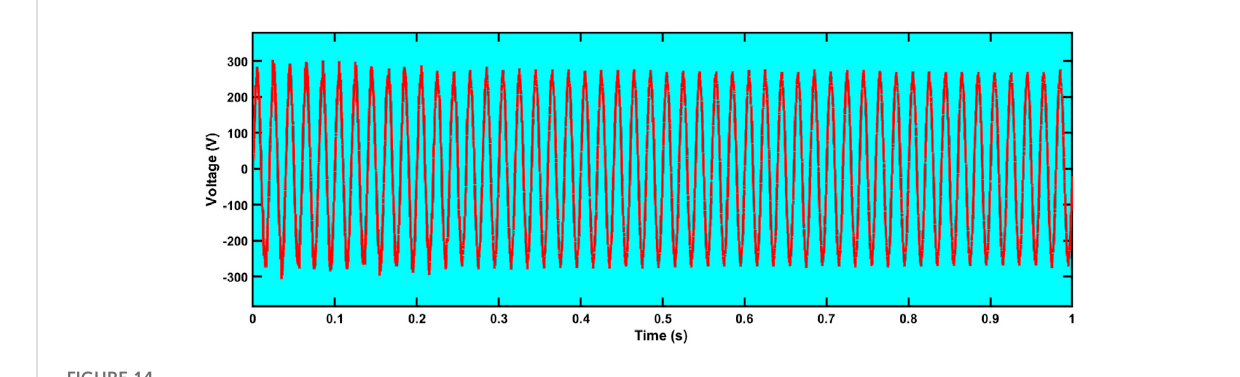
FIGURE 14 Source voltage for varying load.